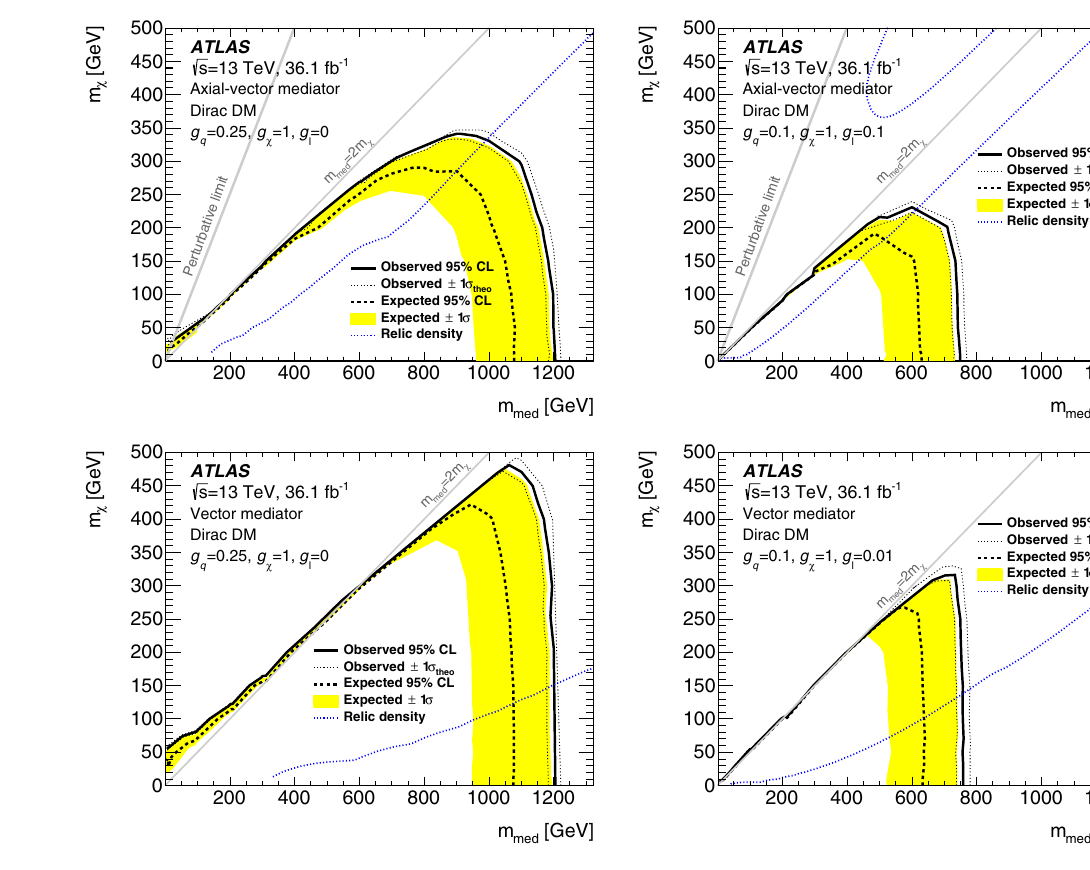
g q = 0 . 1 , g χ = 1 and g (cid:14) = 0 . 01 ( bottom right ). The region on the left is excluded by the perturbative limit which is relevant for axial- vector mediators [77]. The relic density curve [74,76] is also shown: at higher mediator masses, the DM would be overabundant; at lower values, it would be underabundant; for the axial-vector scenario shown in the upper right figure , the region above the relic density curve at high dark-matter masses is also